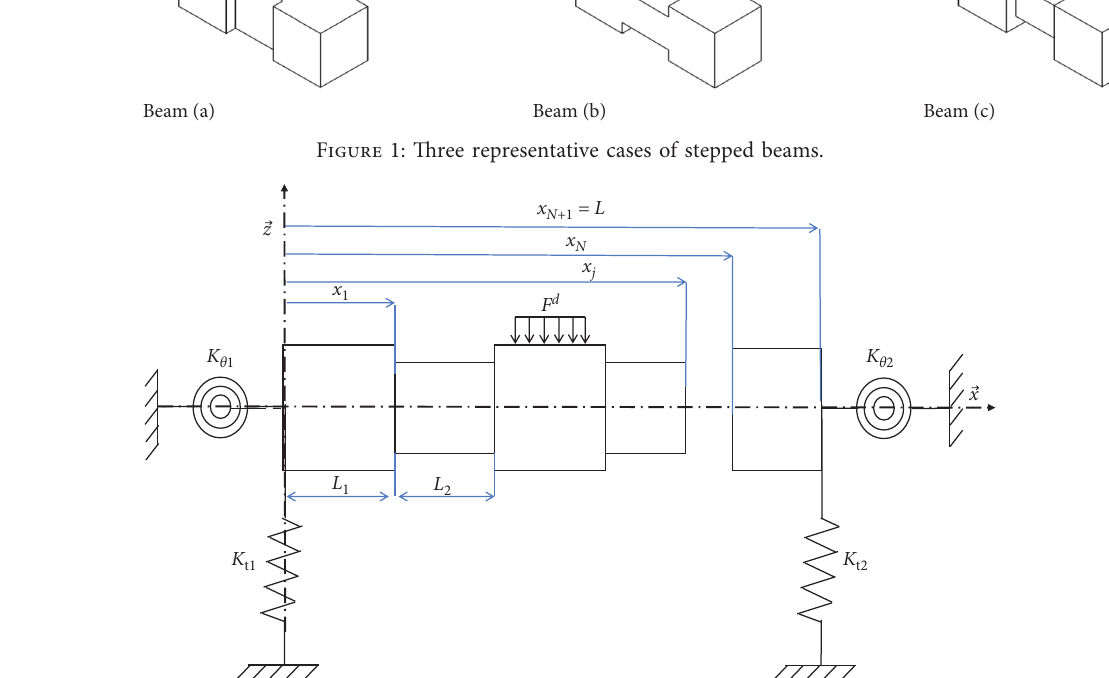
Figure 2: The coordinate system for a multistepped